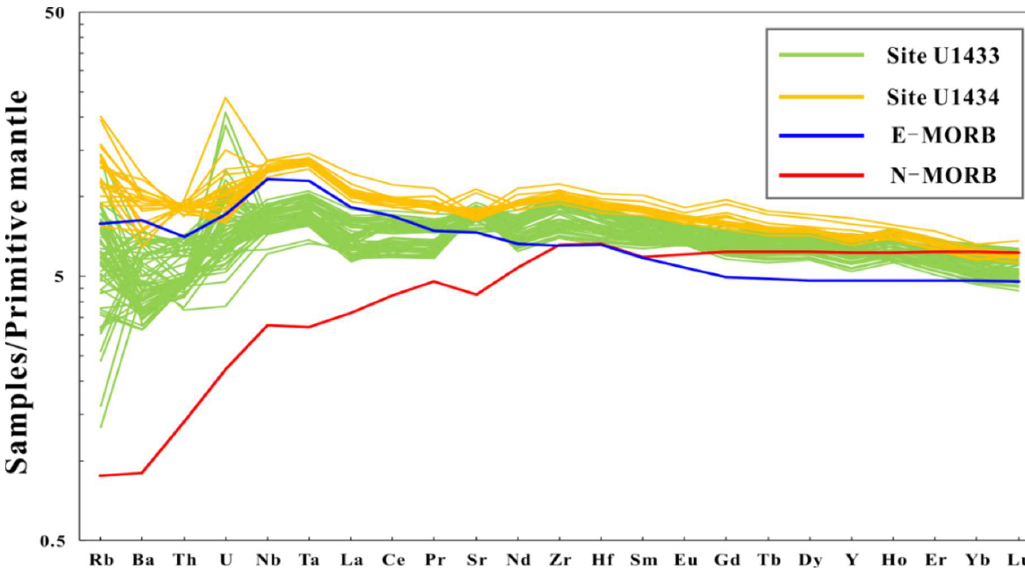
Figure 6. Primitive mantle-normalized spider grams for basaltic samples from Sites U1433 and